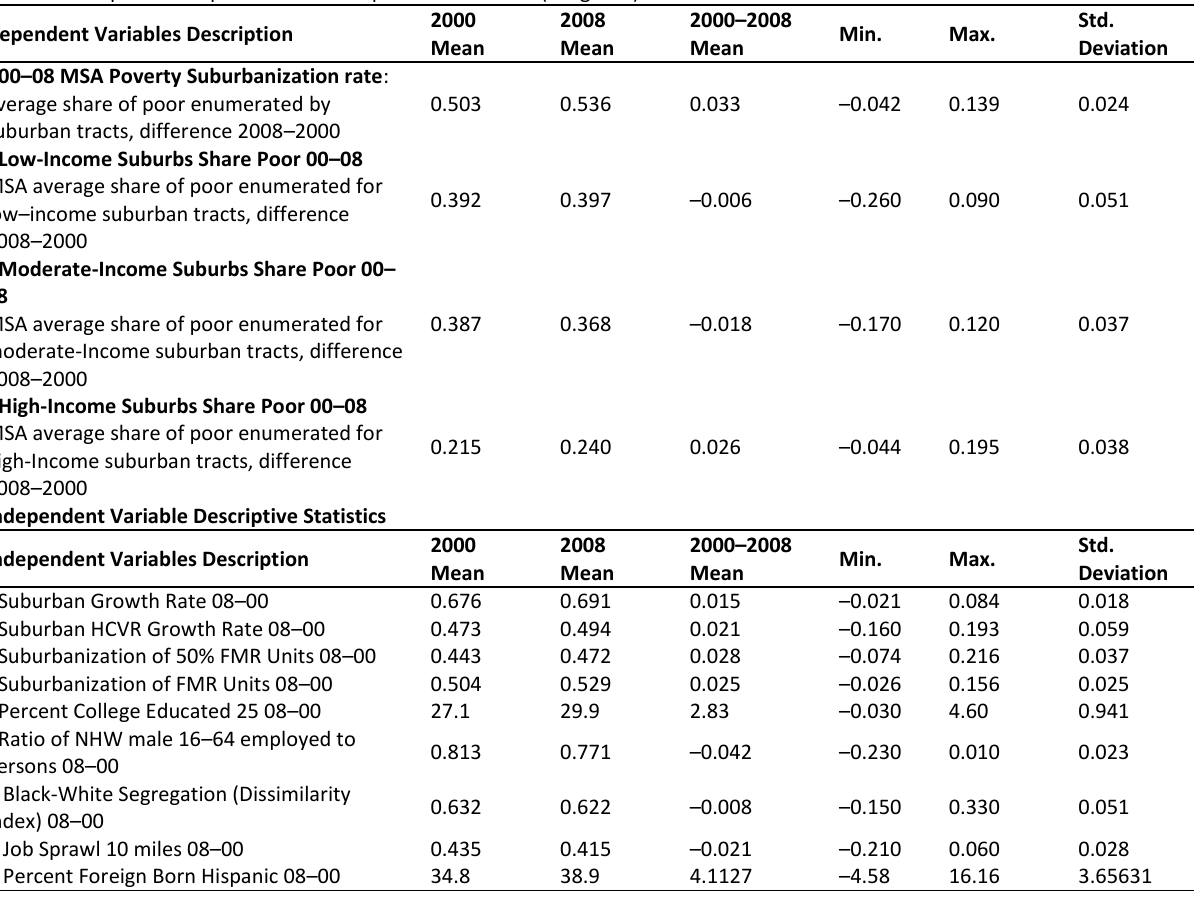
Table 1. Description of dependent and independent variables